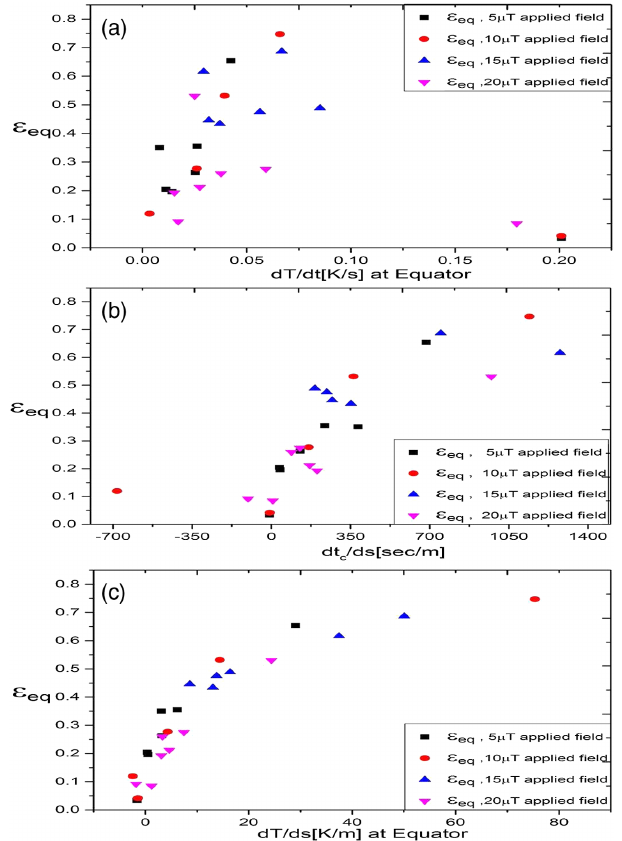
FIG. 4. The flux expulsion ratio ϵ as a function of the cooling eq rate (a), the inverse of the propagation speed of the phase transition front (b) and the temperature gradient (c) when the NC-SC phase transition front arrives at the equator under various applied magnetic fields. The definition of ϵ is given by Eq. eq